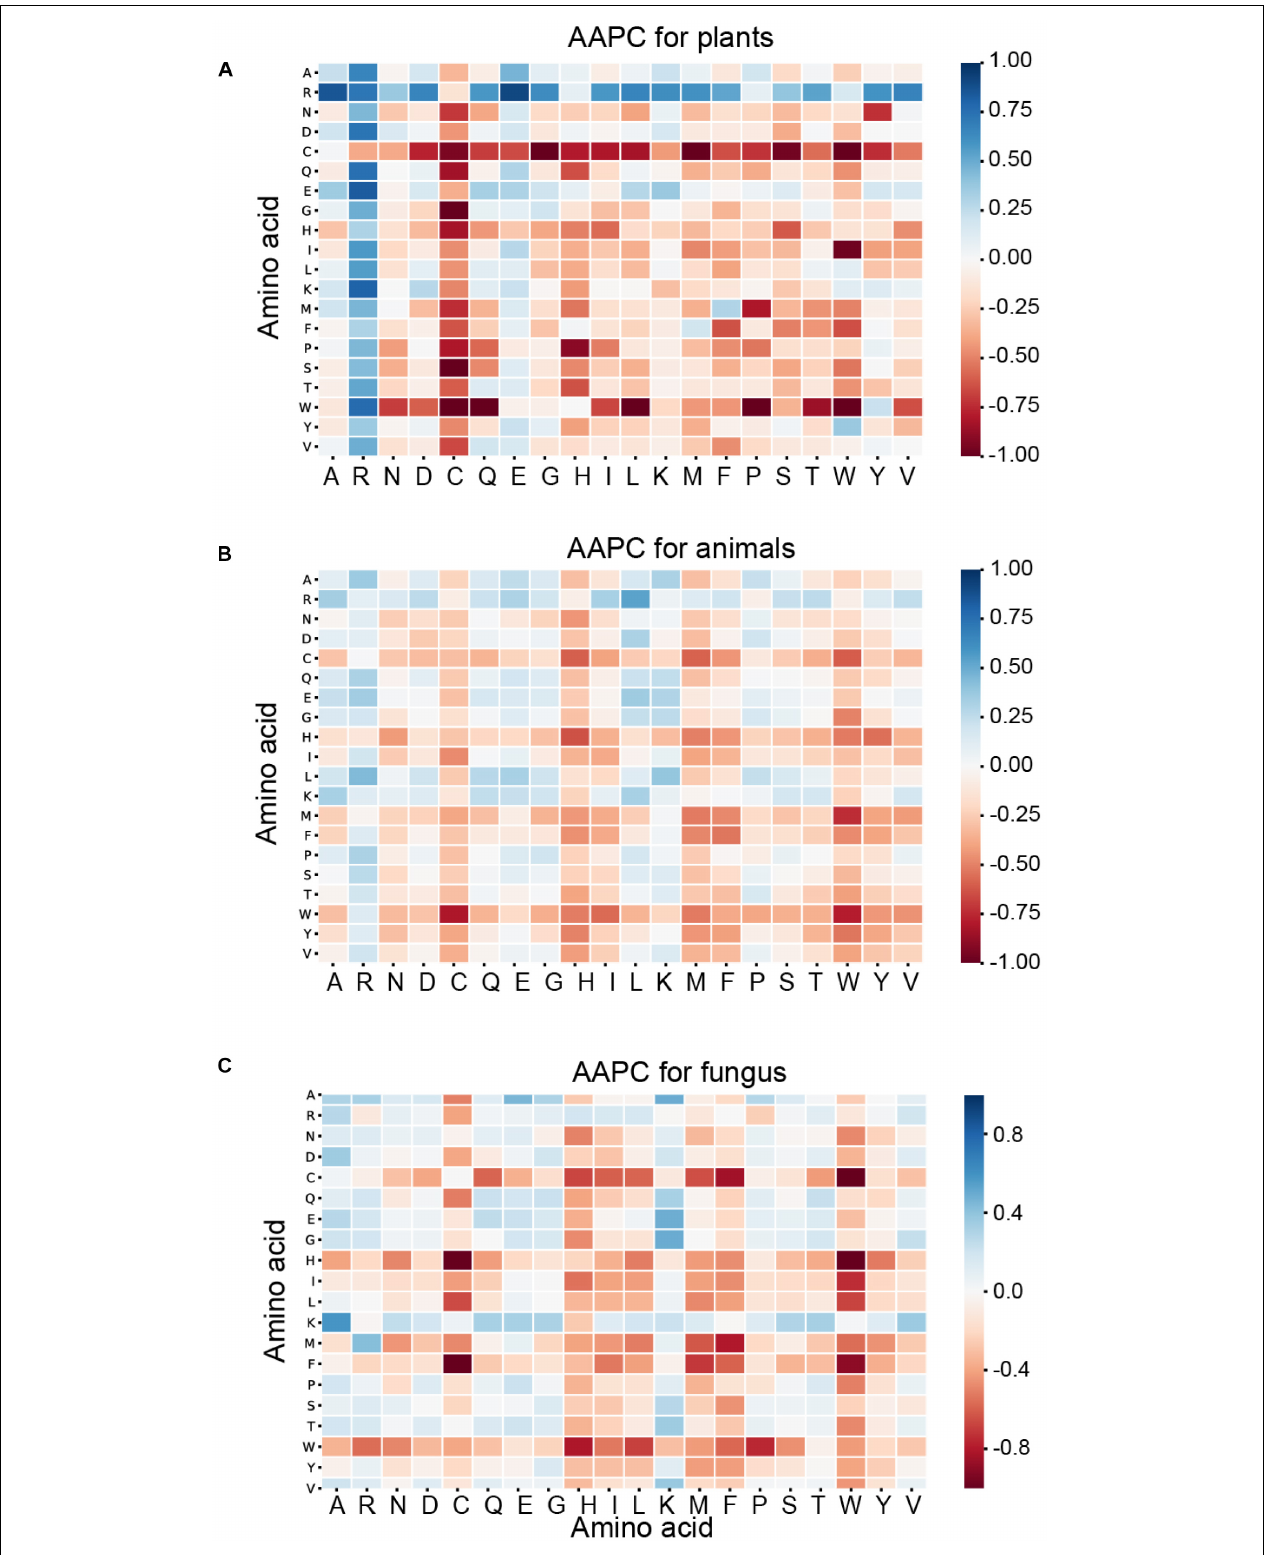
FIGURE 5 | Heatmaps for the amino acid pairwise composition (AAPC) features of three species. (A) Heatmap for the AAPC features of plants. (B) Heatmap for the AAPC features of animals. (C) Heatmap for the AAPC features of fungi.